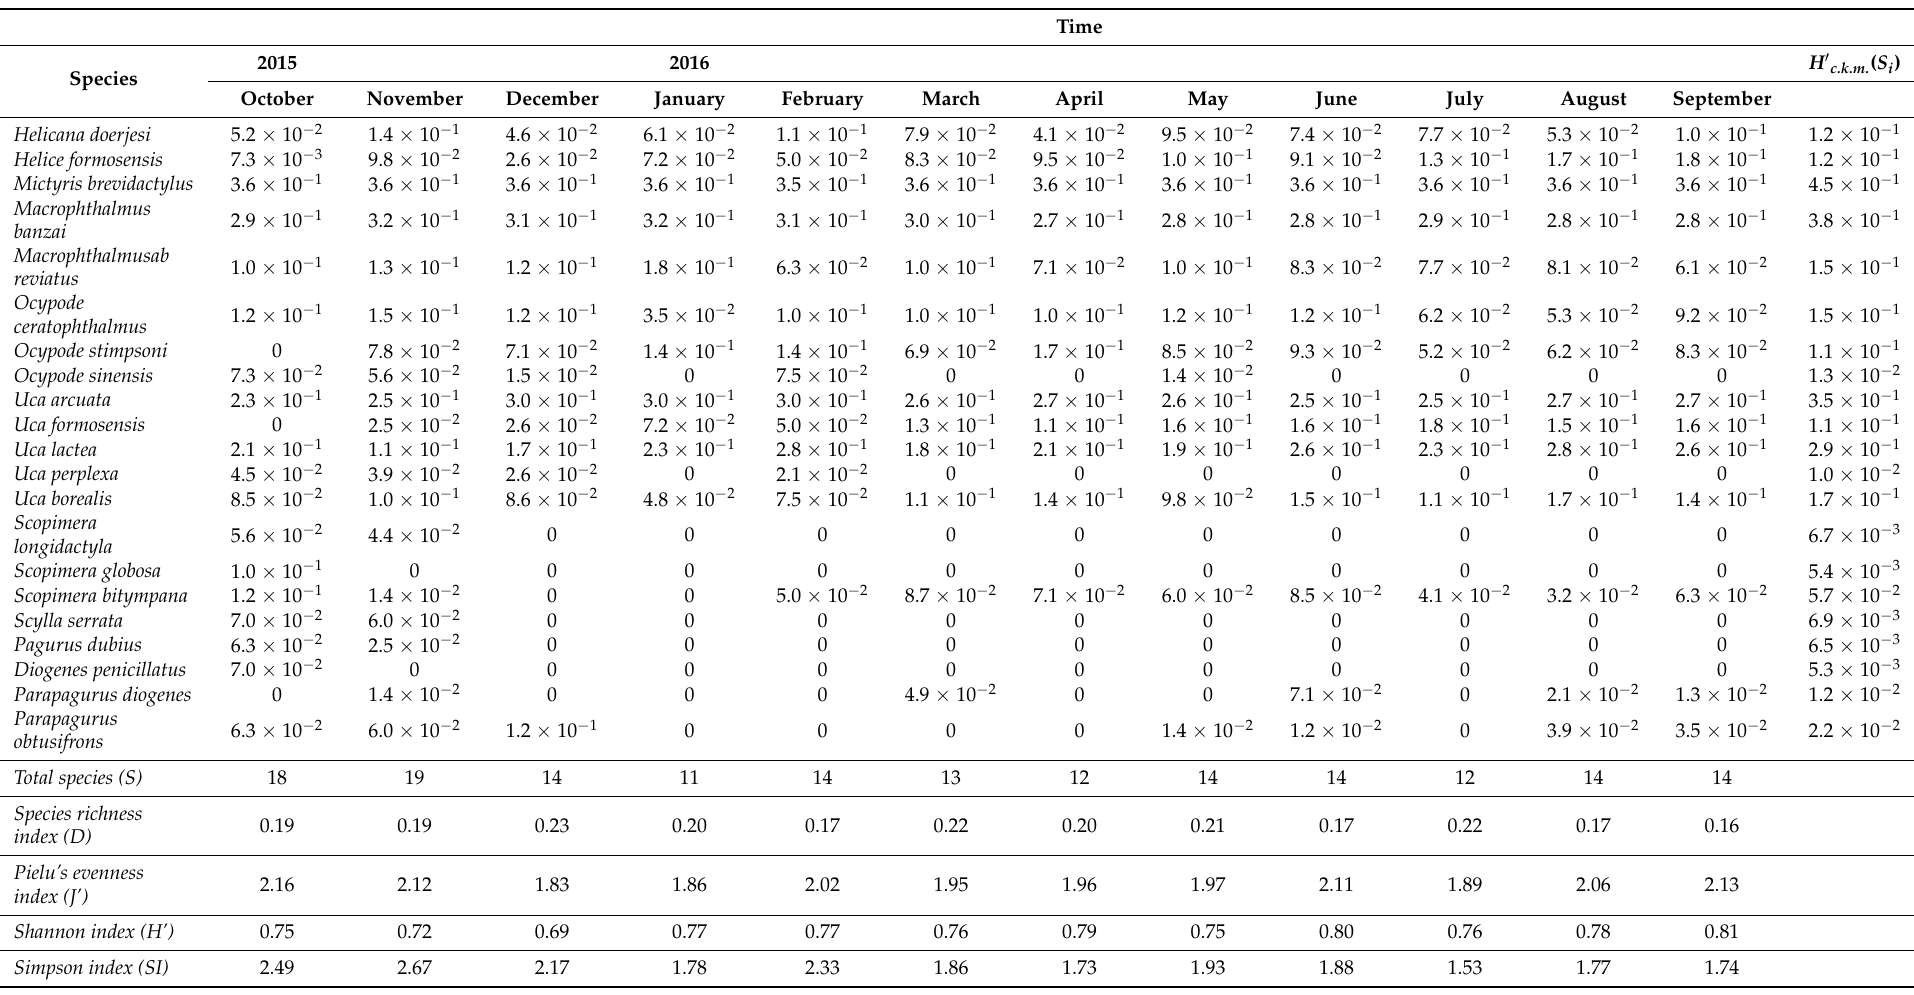
Table A1. Probabilities of contribution to biodiversity ( H (cid:48) c.k.m. ) by crab species ( S i ) by